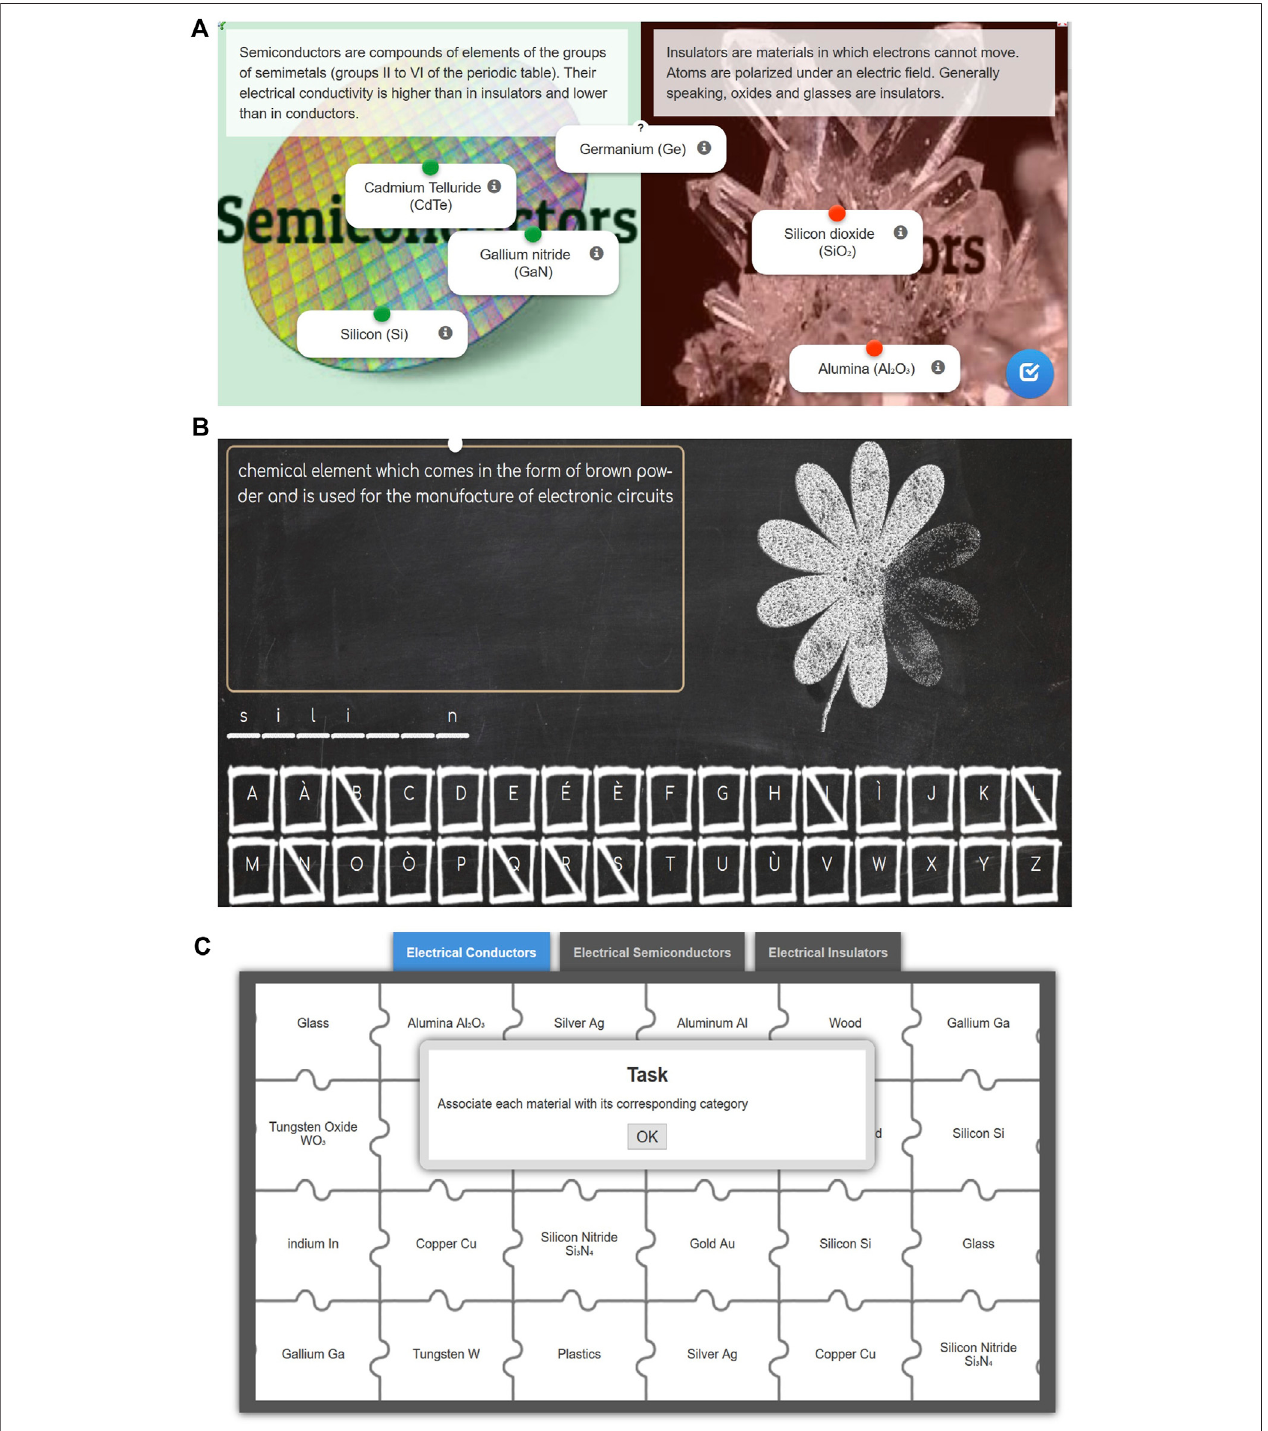
FIGURE 3 | Screenshots of the digital games created by students of Class 5: (A) the “ semiconductor or insulator? ” quiz; (B) the “ hangman game ” ; (C) a puzzle associating each material to the corresponding category.